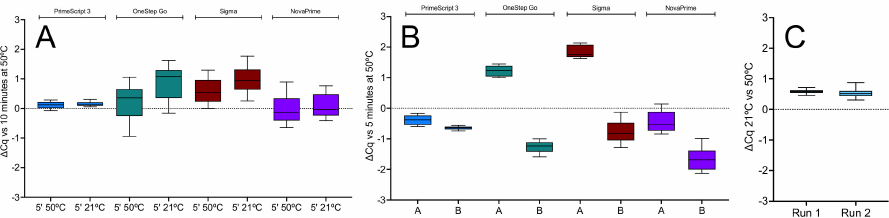
Figure 6. The 1-step RT-qPCR assays targeting E1 carried out with PrimeScript 3 (blue), OneStep Go (green), Sigma (brown) and NovaPrime (purple) master mixes. ( A ) ∆ Cqs of 5 min RT reactions carried out at 50 or at 21 ◦ C against 10 min RT reactions. ( B ) ∆ Cqs from two replicate 5 min RT reactions ( A , B ) carried out at 21 ◦ C relative to a 5 min RT reaction carried out at 50 ◦ C. ( C ) ∆ Cqs recorded for two runs of ten RT replicates of the E1 assay on the BMS Mic instrument. The scales of the y-axes were adjusted to a common scale to simplify the comparison between the runs and instruments. All box and whiskers plots show the ∆ Cqs for the independent RT-qPCR reaction, with the whiskers delineating the minimum and maximum